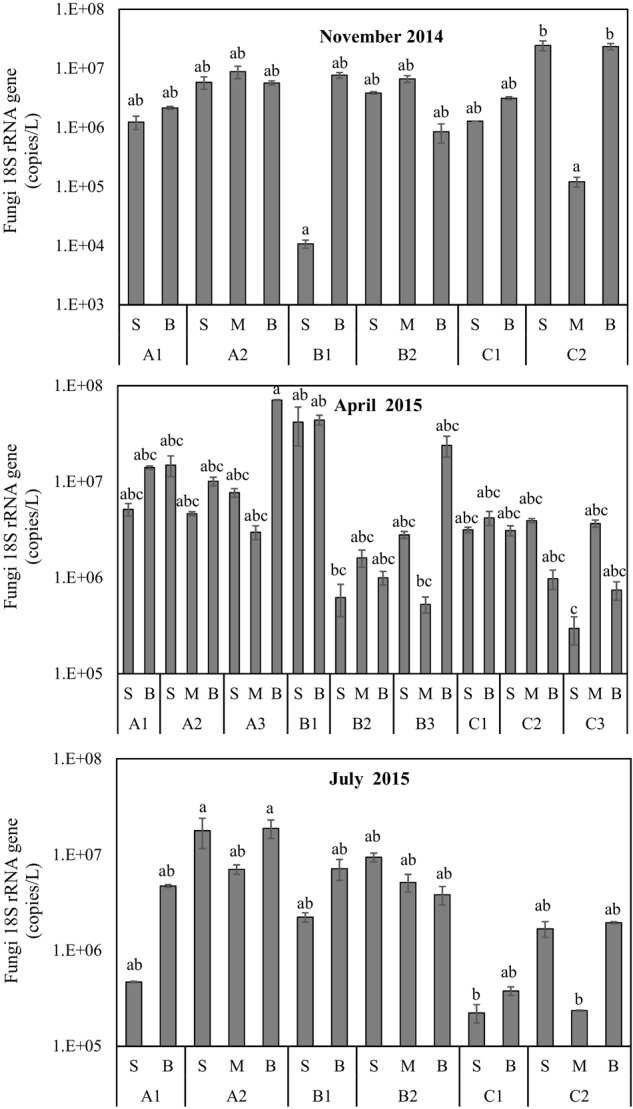
Planktonic fungal abundance determined by Fungi-specific 18S rRNA gene qPCR of plankton DNA samples collected from Qinhuangdao coastal area from November 2014 to July 2015. Samples of each month with significant mean differences (P < 0.05) based on Kruskal–Wallis post hoc test (Nemenyi-tests) are marked in different letters (a, b, c). Thus, samples (bars) that are not significantly different are indicated with same letters (for e.g., ‘abc’) and sample pairs with significant differences will have different letters.